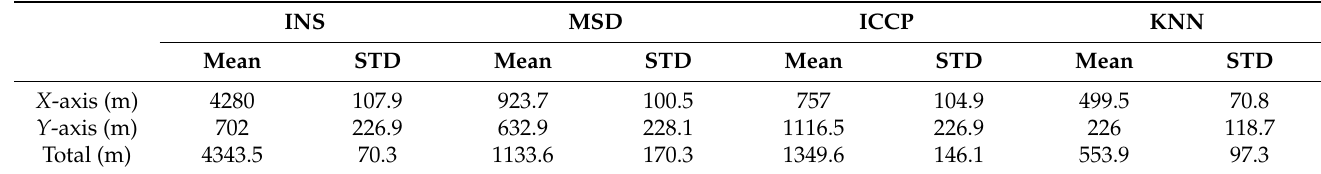
Table 6. Statistics of positioning errors of track